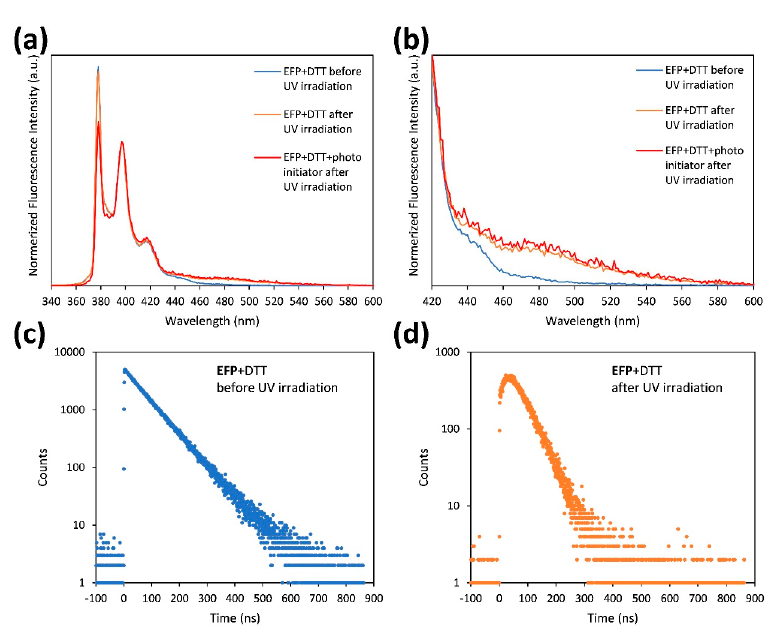
Figure 2. Fluorescence spectra and fluorescence lifetime measurements of EFP + DTT before UV irradiation (blue), EFP + DTT after UV irradiation (orange), and EFP + DTT + photoinitiator after UV irradiation (red) in DMSO. The fluorescence was excited at 342 nm. EFP concentration in the reaction mixture was 2.71 × 10 − 2 M and was diluted to the concentration of 8.67 × 10 − 6 M for fluorescence measurements. ( a ) Spectra between 340 and 600 nm. ( b ) Spectra between 420 and 600 nm displayed on a larger scale. After UV irradiation, the spectra showed a broad fluorescence peak in the range of 460–560 nm, which was deduced to derive from pyrene excimers. Fluorescence lifetime measurement of ( c ) EFP + DTT (blue dots; measured at 378 nm) and ( d ) EFP + DTT after UV irradiation (orange dots; measured at 479 nm) in DMSO. The time-lapse measurement in ( d ) exhibited slow peak rise of the excimer fluorescence, suggesting the dynamic mechanism of excimer